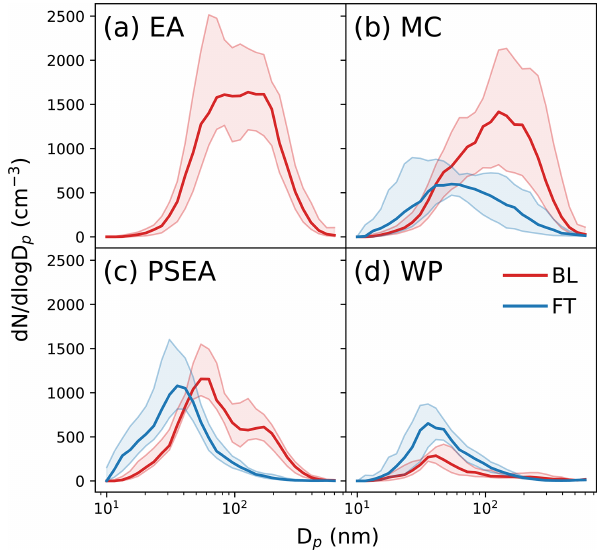
Figure 8. Median FIMS number size distributions (d N/ dlog D p ; cm − 3 ) as a function of geometric mean particle diameter ( D p ; nm), resolved by source region and sampling altitude in the boundary layer (BL; < 2km) and free troposphere (FT; > 2km). Source re- gions are peninsular Southeast Asia (PSEA), the Maritime Conti- nent (MC), East Asia (EA), and the West Pacific (WP). Upper and lower bounds of the shaded areas refer to 25th and 75th percentiles, respectively. The size distribution of EA air in the FT was not plot- ted due to the infrequent sampling of EA air in the